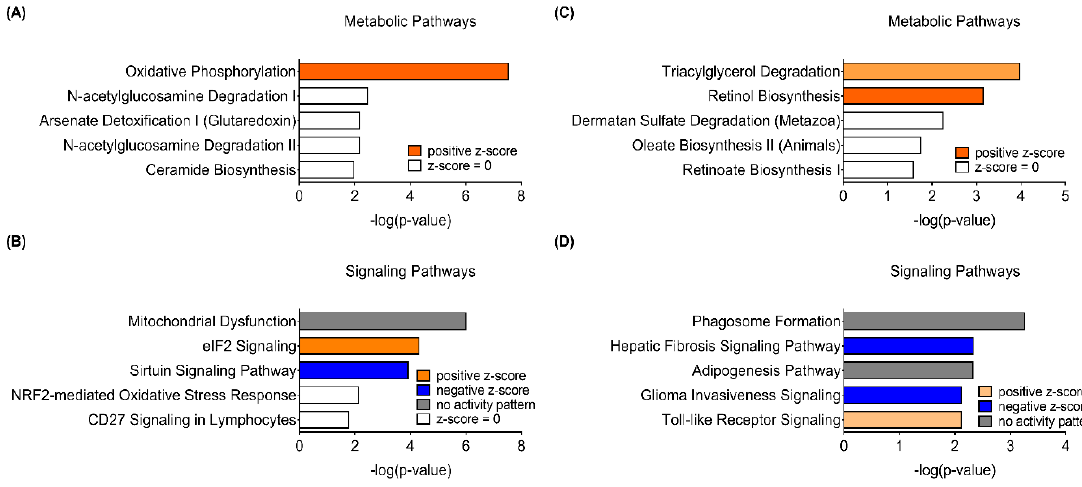
Figure 2. Canonical pathways retrieved from the colon transcriptome of male ( A , B ) and female ( C , D ) mice treated with 2-amino-1-methyl-6-phenylimidazo[4,5-b]pyridine (PhIP) using the Ingenuity Pathway Analysis (IPA) software. ( A , C ) Top five canonical metabolic pathways enriched in di ff erentially expressed genes of colon transcriptome. ( B , D ) Top five canonical signaling pathways enriched in differentially expressed genes of the colon transcriptome. Table 1. List of genes involved in key canonical pathways predicted by the Ingenuity Pathway Analysis (IPA) software.